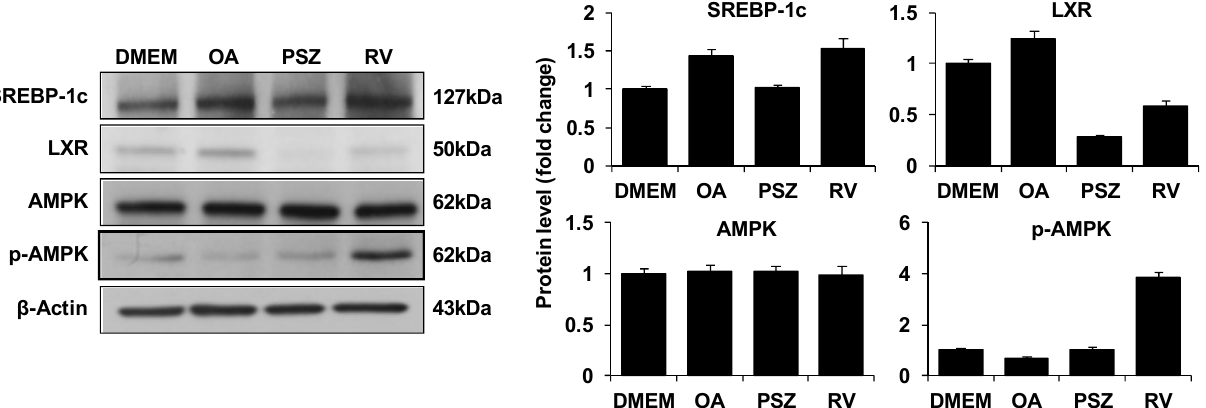
Figure 5. Effects of Pinus densiflora Sieb. et Zucc. (PSZ) on expression of the transcription factor for lipogenic genes in HepG2 cells stimulated with oleic acid (OA). HepG2 cells were treated with 100 μ g/mL PSZ and OA. After treatment for 24 h, whole-cell lysates were subjected to western blot analyses for anti-SREBP-1c, LXR, and AMPK antibodies. β -Actin was used as the internal control. Results are the mean ± SEM from three independent experiments. DMEM, control group; OA, oleic acid-treated group; PSZ, OA + Pinus densiflora Sieb. et Zucc.-treated group; RV, OA + resveratrol-treated